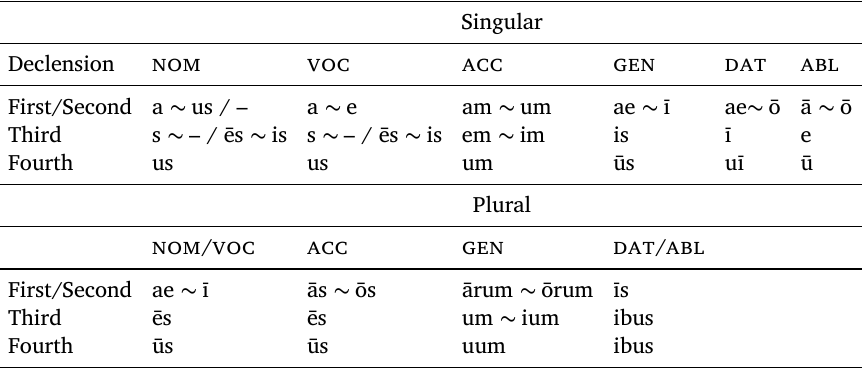
Table 4: Table from Carstairs-McCarthy (1994, p.